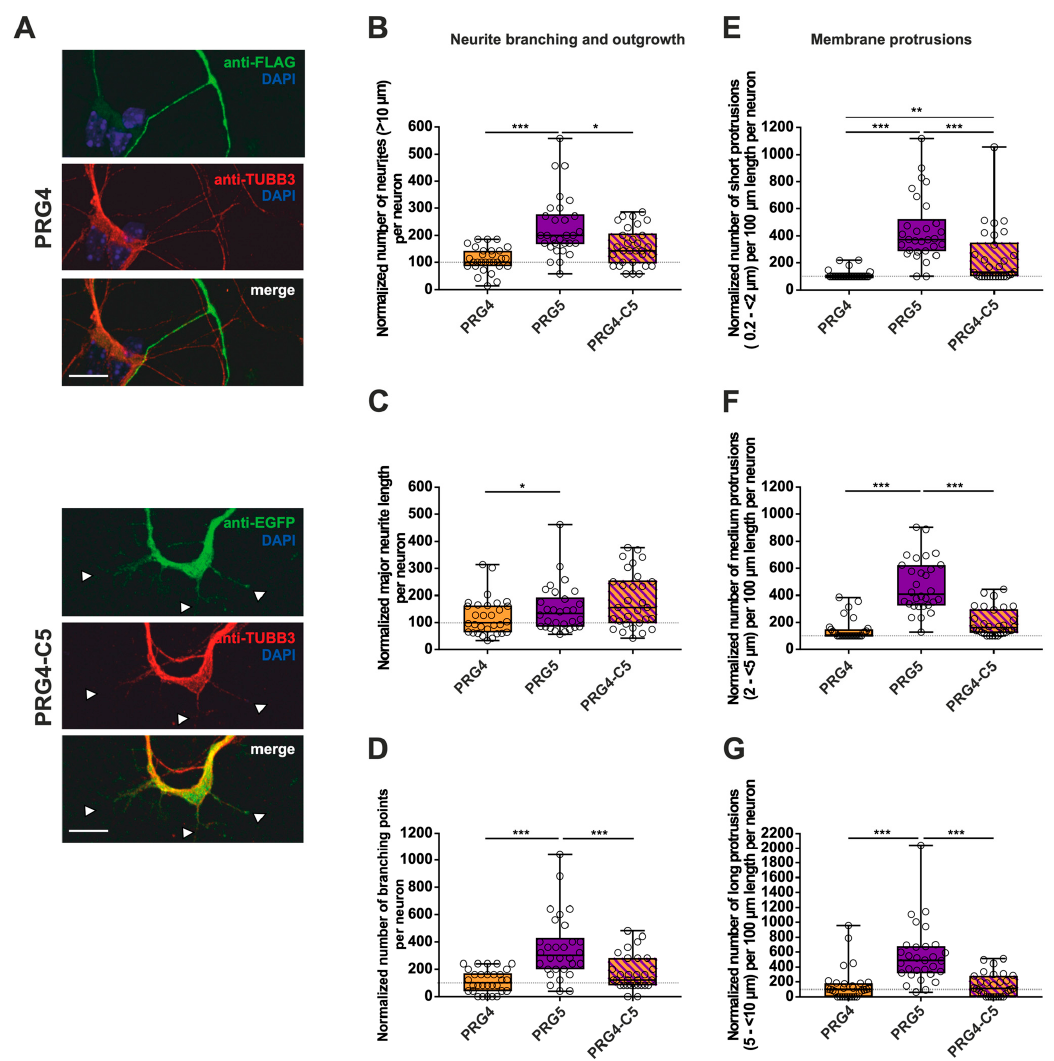
Figure 7. The PRG5 C-terminal domain is important in the early development of hippocampal neurons, but not sufficient to restore the full function of PRG5 when fused to PRG4. Subcellular distribution of PRG4- and PRG4-C5-encoding fusion proteins in immature primary hippocampal neurons in culture (note that the images of PRG4 are the same as in Figure 6A for better comparison). Hippocampal neurons in culture were transfected at DIV1 with ( A ) either PRG4- (upper panel) or PRG4-C5-encoding plasmids (lower panel) and analyzed at DIV2. Confocal stacks of representative neurons with immunocytochemistry of the respective fusion proteins stained for FLAG (green, PRG4) or GFP (green, PRG4-C5) to visualize the morphology of the cell or tubulin are shown. Arrowheads denote areas showing membrane localization. The scale bar represents 10 µ m. Boxplots showing the quantification of ( B ) the total number of neurites (*** p ≤ 0.0001, * p ≤ 0.01); (C) the quantification of major neurite length (* p ≤ 0.01), and ( D ) the number of branching points (*** p ≤ 0.001) in PRG4- PRG5- and PRG4-C5-overexpressing neurons. Quantification of membrane protrusions in subgroups based on length in the ( E ) group of short protrusions (0.2–<2 µ m) (*** p ≤ 0.0001; ** p ≤ 0.001) and of ( F ) medium protrusions (2–<5 µ m) and ( G ) long protrusions (5–<10 µ m) (*** p ≤ 0.0001). (PRG4 n = 30, PRG5 n = 30, PRG4-C5 n = 30 neurons). All data are presented as median and IQR. Boxes range from 1st to 3rd quartile. Horizontal lines represent medians. Whiskers represent minimum and maximum. Dots represent the values of individual neurons. Statistical analysis was performed using the Kruskal–Wallis test. A level of confidence of p ≤ 0.05 was adopted (* p ≤ 0.05, ** p ≤ 0.01, *** p ≤ 0.001). PRG4 was always set to 100 and ratios of changes of the different morphology analyses are shown ( B – G